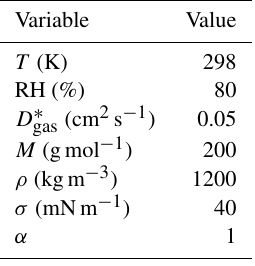
Table 2. The ambient conditions and properties of the organic com- pounds in the artificial test data that are the same for all compounds in artificial data sets 1–4. The variables are, from top to bottom, temperature, relative humidity, gas-phase diffusion coefficient, mo- lar mass, particle-phase density of the pure compound , particle sur- face tension and mass accommodation